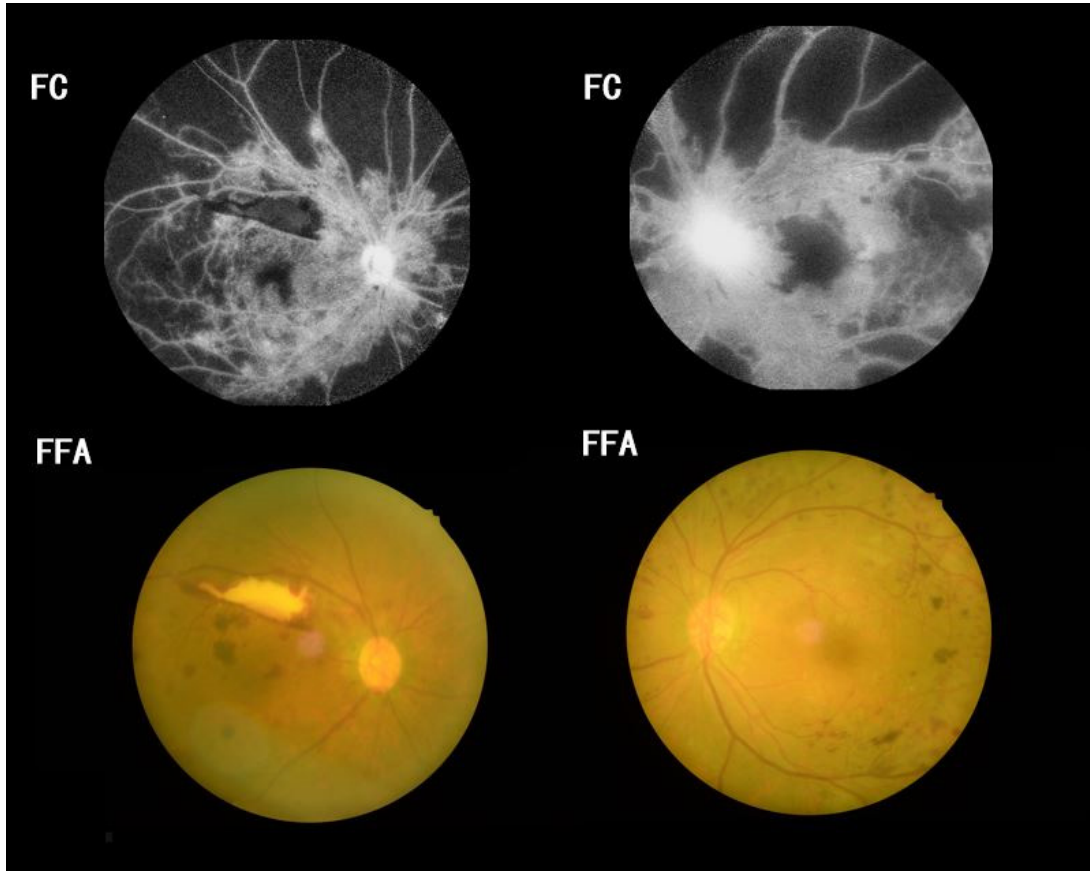
Fig.1. ExamplesFCandFFAofNVGinapatientwithischemiccentralretinalveinocclusion. FC, fundus camera; FFA, fluorescence fundus angiog-